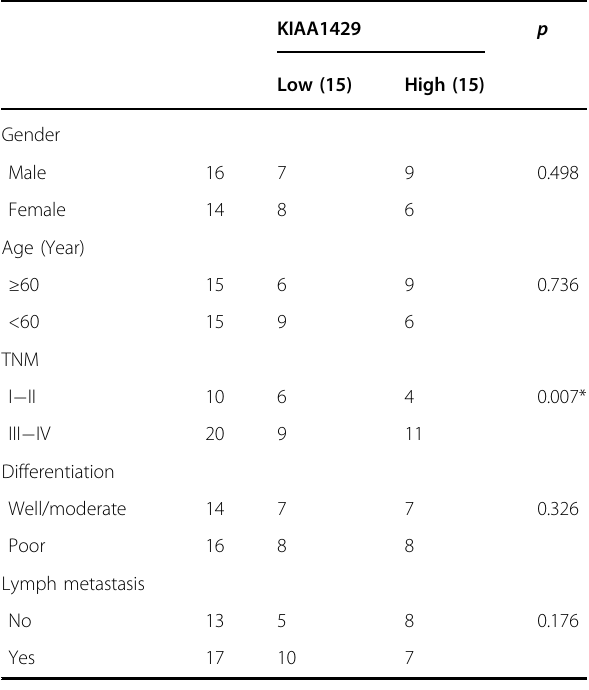
Table 1 Clinicopathological feature of NSCLC patients with KIAA1429